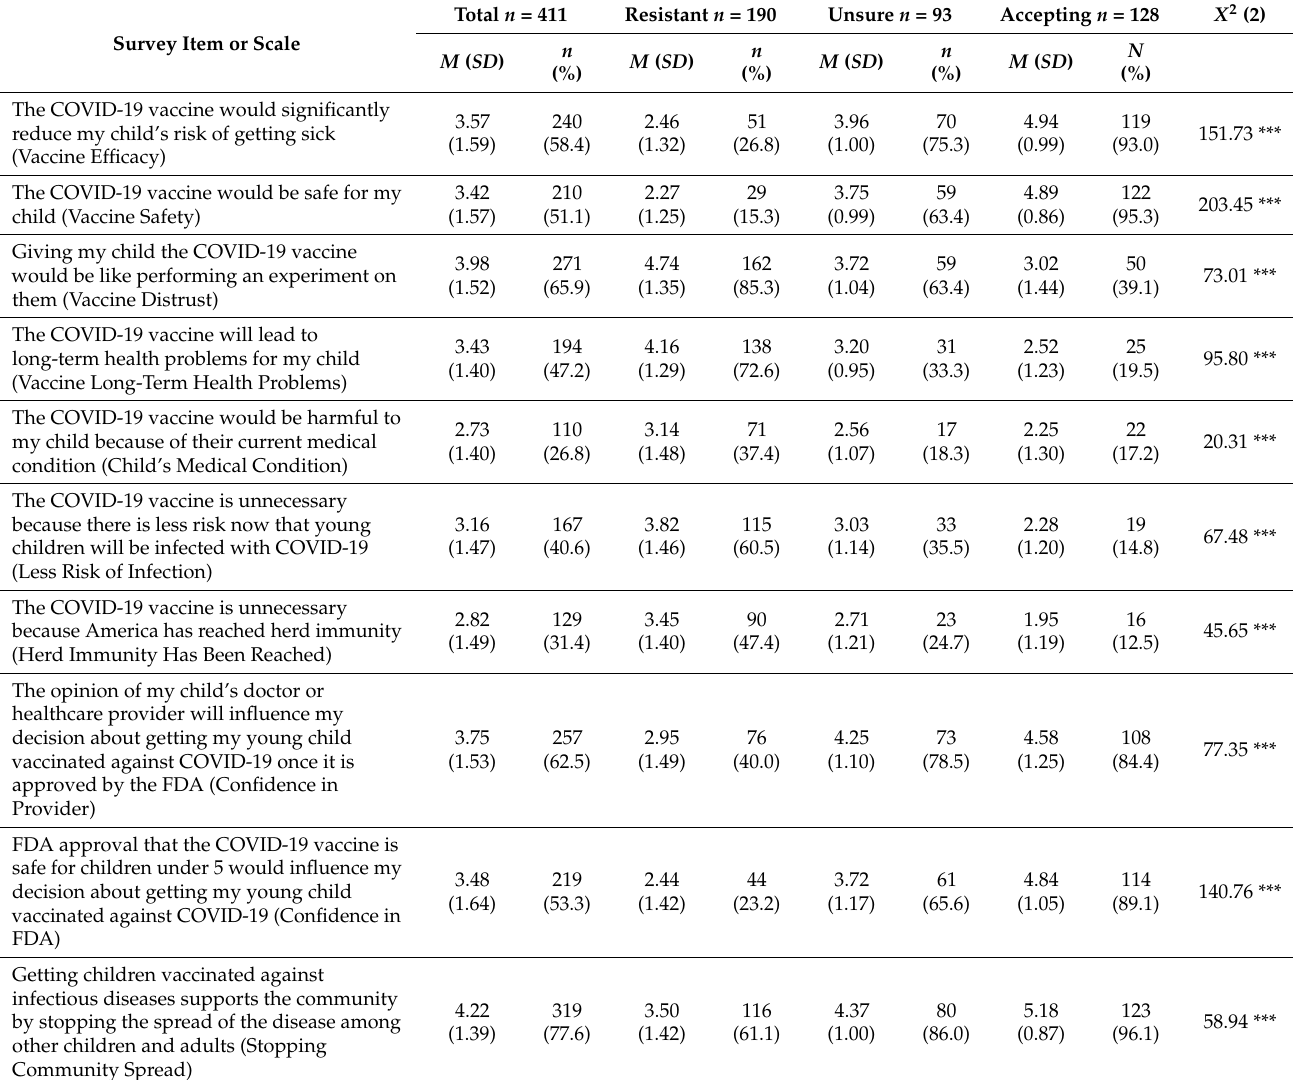
Table 2. Frequencies/percentages of agreement and means/standard deviations for parental COVID-19 pediatric vaccination beliefs and Chi square analyses across vaccine intent